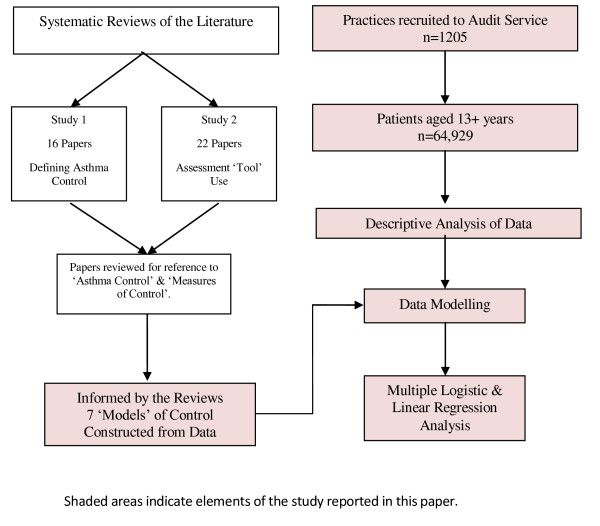
Flow of the study.